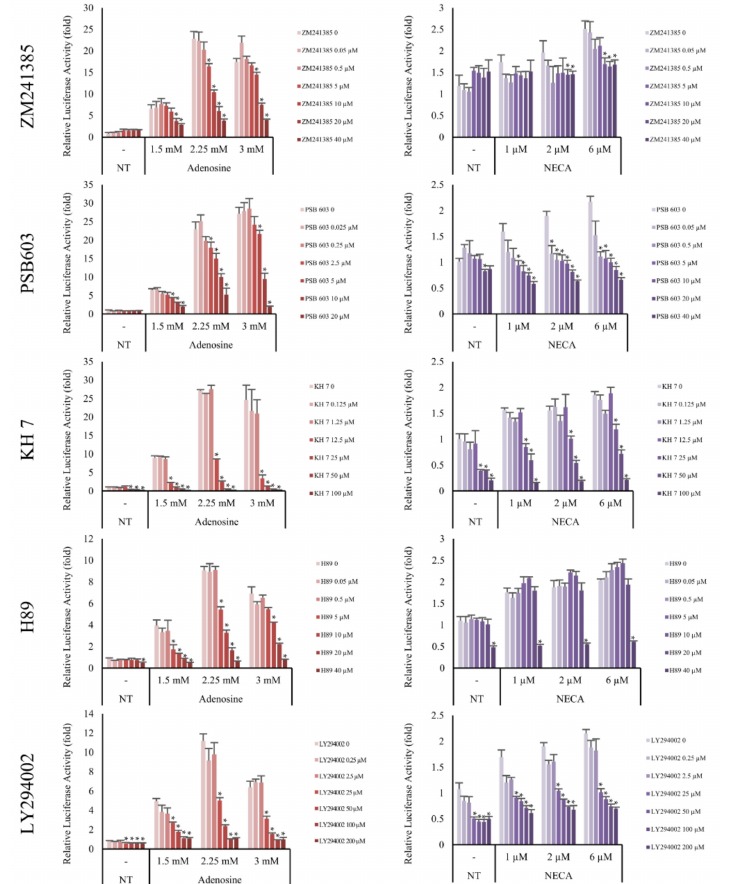
Figure 7. Adenosine A 2A and A 2B receptor antagonists inhibited adenosine mediated-Wnt/ β -catenin signaling. The luciferase activity in WRHEK293A reporter cells was evaluated after treatment with adenosine and NECA for 24 h in the presence/absence of adenosine A 2A and A 2B receptor antagonists, ZM241385 and PSB603, respectively. Both inhibitors blocked Wnt/ β -catenin reporter activity. The effects of the adenylyl cyclase inhibitor (KH7), PKA inhibitor (H89), and mTOR inhibitor (LY294002) were also examined. Adenosine-mediated Wnt activation was inhibited by KH7, H89, and LY294002. NECA was used as a positive control for adenosine A 2A and A 2B receptor activation. The data represent the means of six independent samples. N.T, non-treated control; Significantly different compared with N.T (* p <